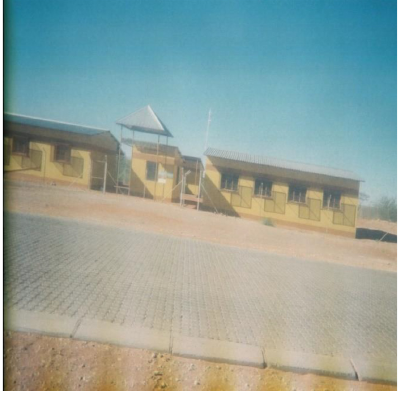
Figure 4. Multipurpose